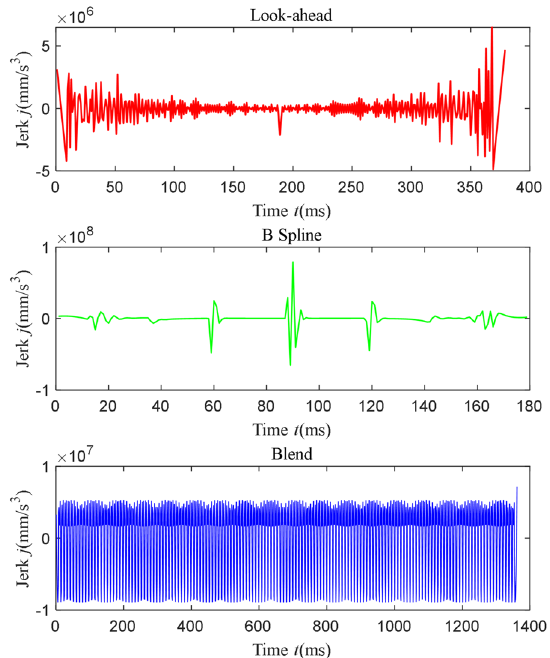
Figure 8 Comparison of jerk values for the three